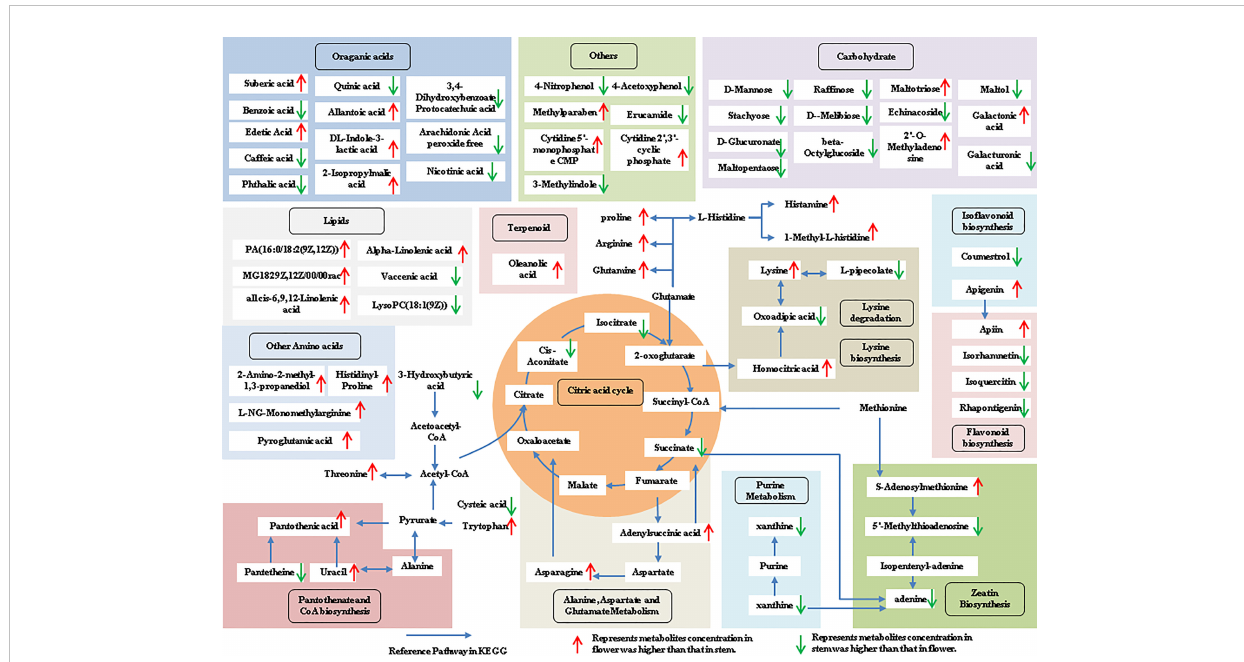
FIGURE 6 Metabolic pathways analysis in fl ower-stem group of P. cablin . The 77 metabolites identi fi ed in fl ower-stem group were mapped onto primary and secondary metabolism. The upward-pointing red arrows represent the value of |log2| (content fl ower/stem) >1, which means the level of metabolites in fl ower is higher than that in stem, the value of |log2|(content fl ower/stem) <1 represents metabolites concentration in stem was higher than that in fl ower, and represented by downward-pointing green